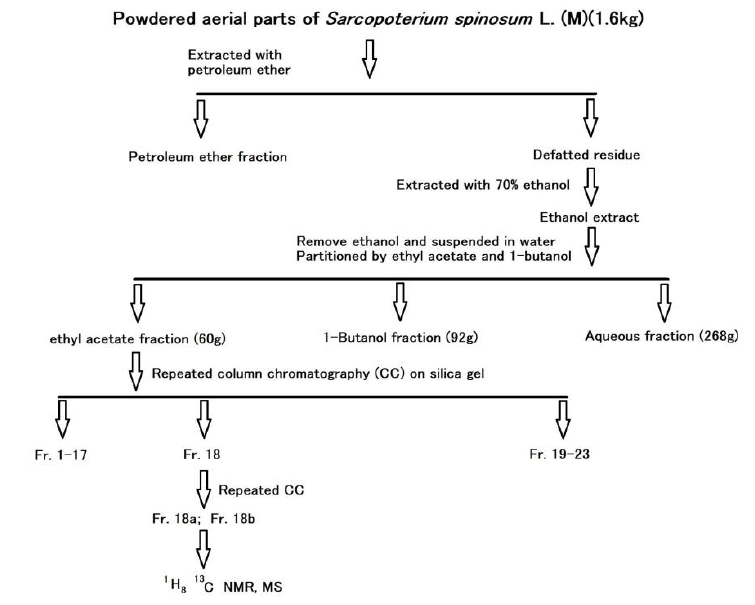
Figure 1. Extraction, fractionation, and column chromatography separation of the aerial parts ex- tracts of S. spinosum (L.). of S. spinosum